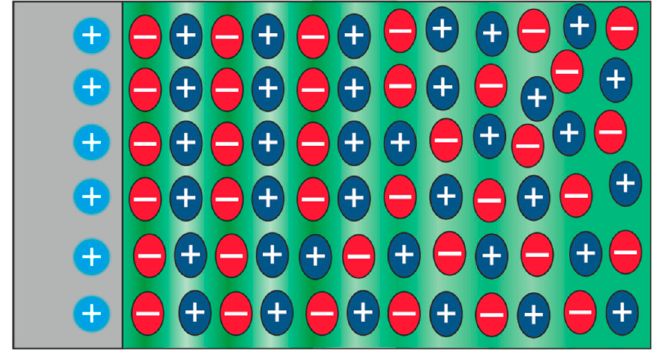
Figure 5. Simplified model of the interface between a positively-charged interface and an ionic liquid.